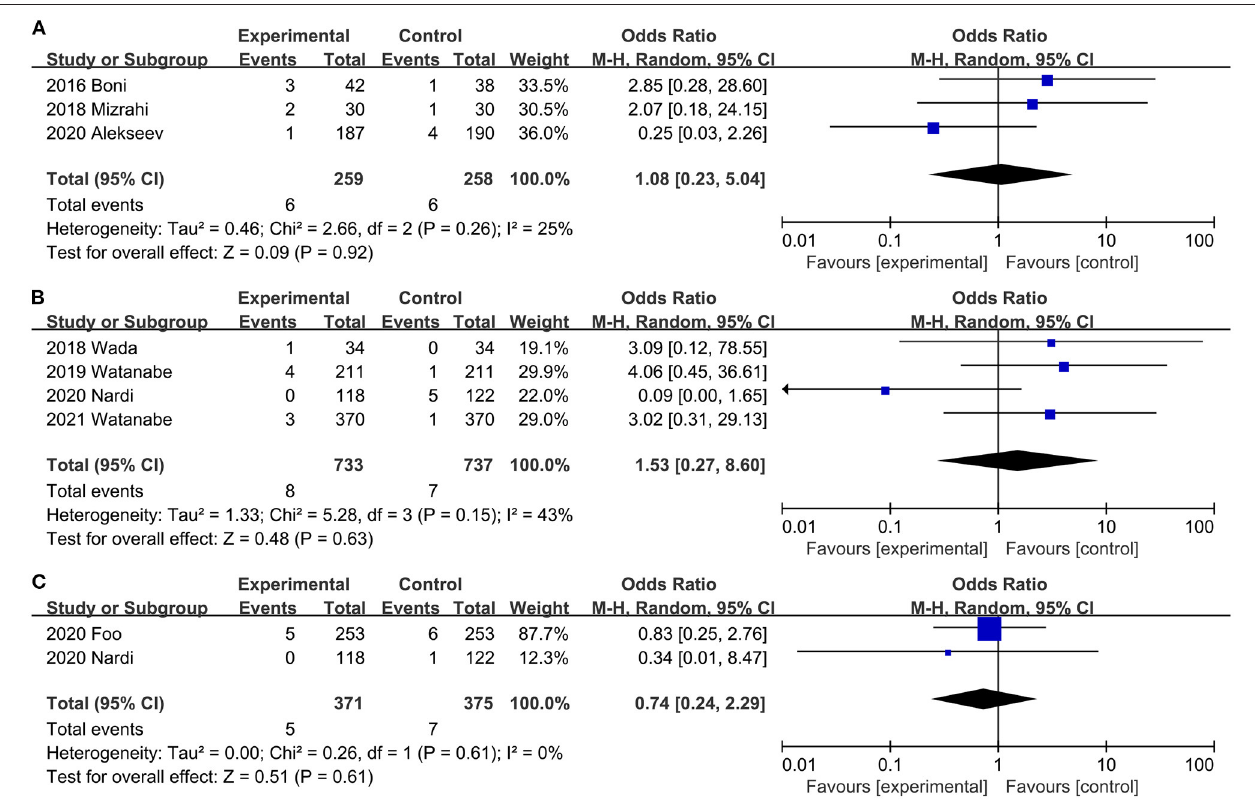
FIGURE 7 | Effect of indocyanine green on (A) Urinary retention rate. (B) Anastomotic bleeding rate (C) Urinary tract infection